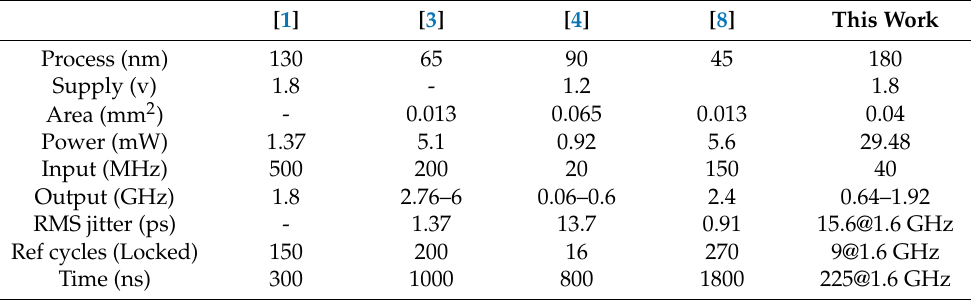
Table 2. NS-ADPLL performance